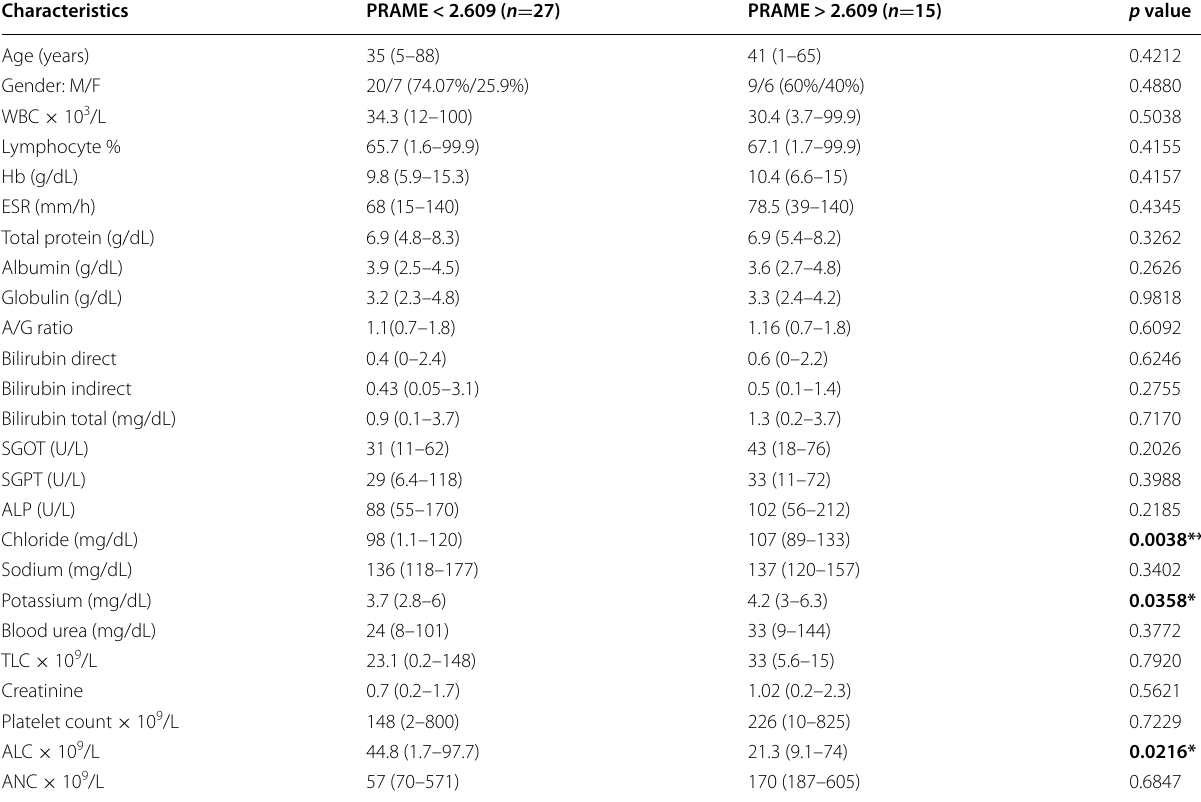
Hb hemoglobulin, ESR erythrocyte sedimentation rate, SGOT Serum glutamic oxaloacetic transaminase, SGPT Serum glutamic pyruvic transaminase, ALP Alkaline phosphatases, TLC Total leucocyte count, ALC Absolute to lymphocyte ratio, NLR Neutrophil to lymphocyte ratio Highlighted values are indicating statistical significance at P < 0.05 (Where, P < 0.05*, P <